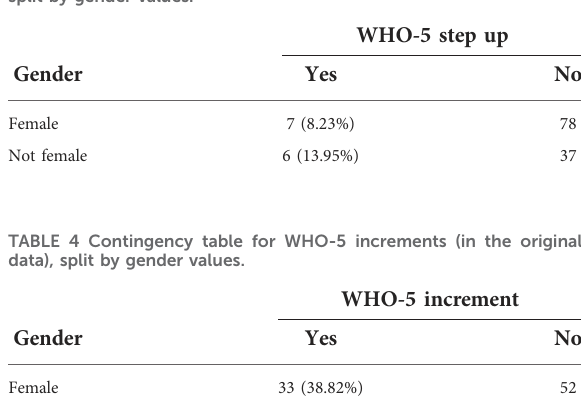
TABLE 3 Contingency table for WHO-5 step ups (in the original data), split by gender